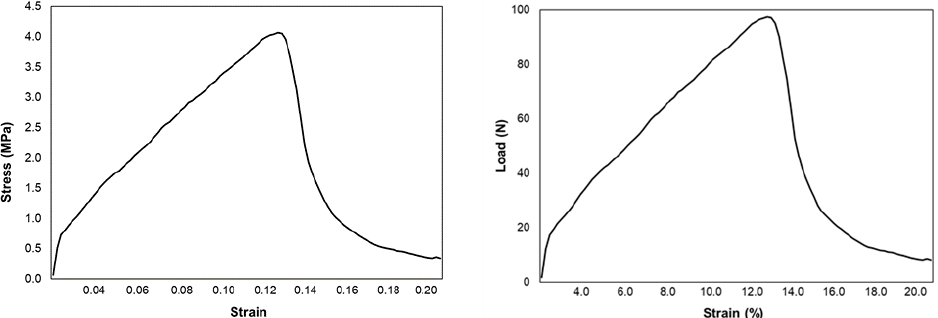
Figure 4. Stress–strain and load–%strain curves of the newspaper sheet. Table 2. Solids analyses of waste samples and